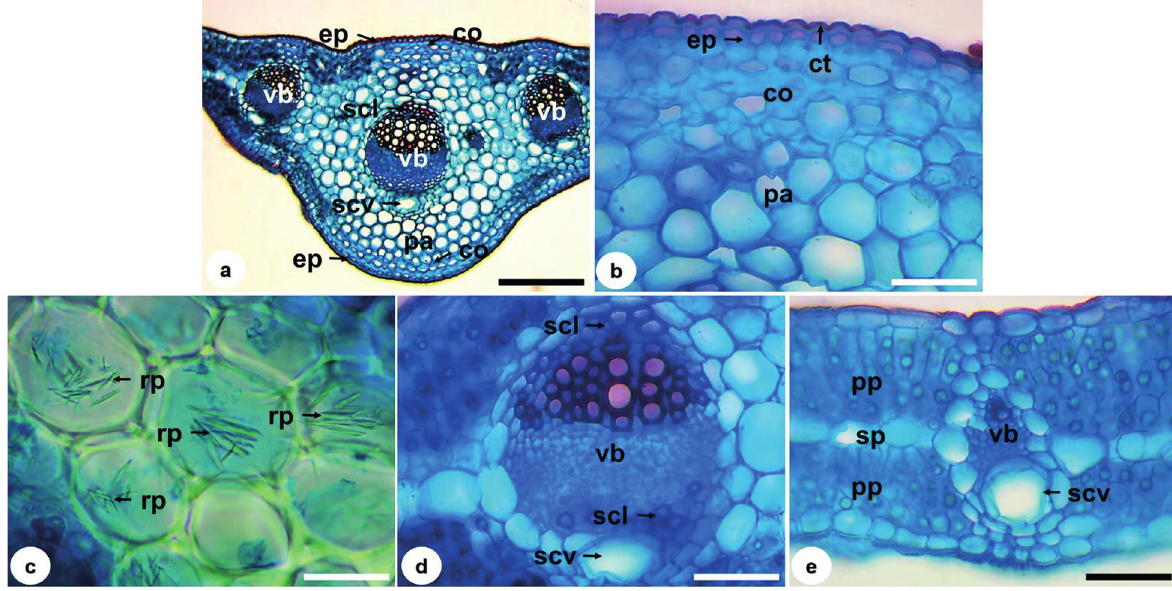
Figure 3 - Solidago chilensis Meyen (Asteraceae), cross-sections of the leaf. (a) View of the midrib, showing epidermis (ep), collenchyma (co), parenchyma (pa), sclerenchyma (scl) and secretory cavity (scv) next to the vascular bundle (vb). (b) Detail of the adaxial region of the midrib, where is observed epidermis (ep) covered by striated cuticle (ct), angular collenchyma (co) and parenchyma (pa). (c) Idioblasts with raphides (rp) in the parenchyma. (d) Detail of sclerenchyma (scl) and secretory cavity (scv) next to the vascular bundle (vb). (e) Detail of palisade parenchyma (pp), spongy parenchyma (sp) and secretory cavity (scv) next to the vascular bundle (vb). Bars: a = 200 µm; b , d and e = 50 µm; c = 20